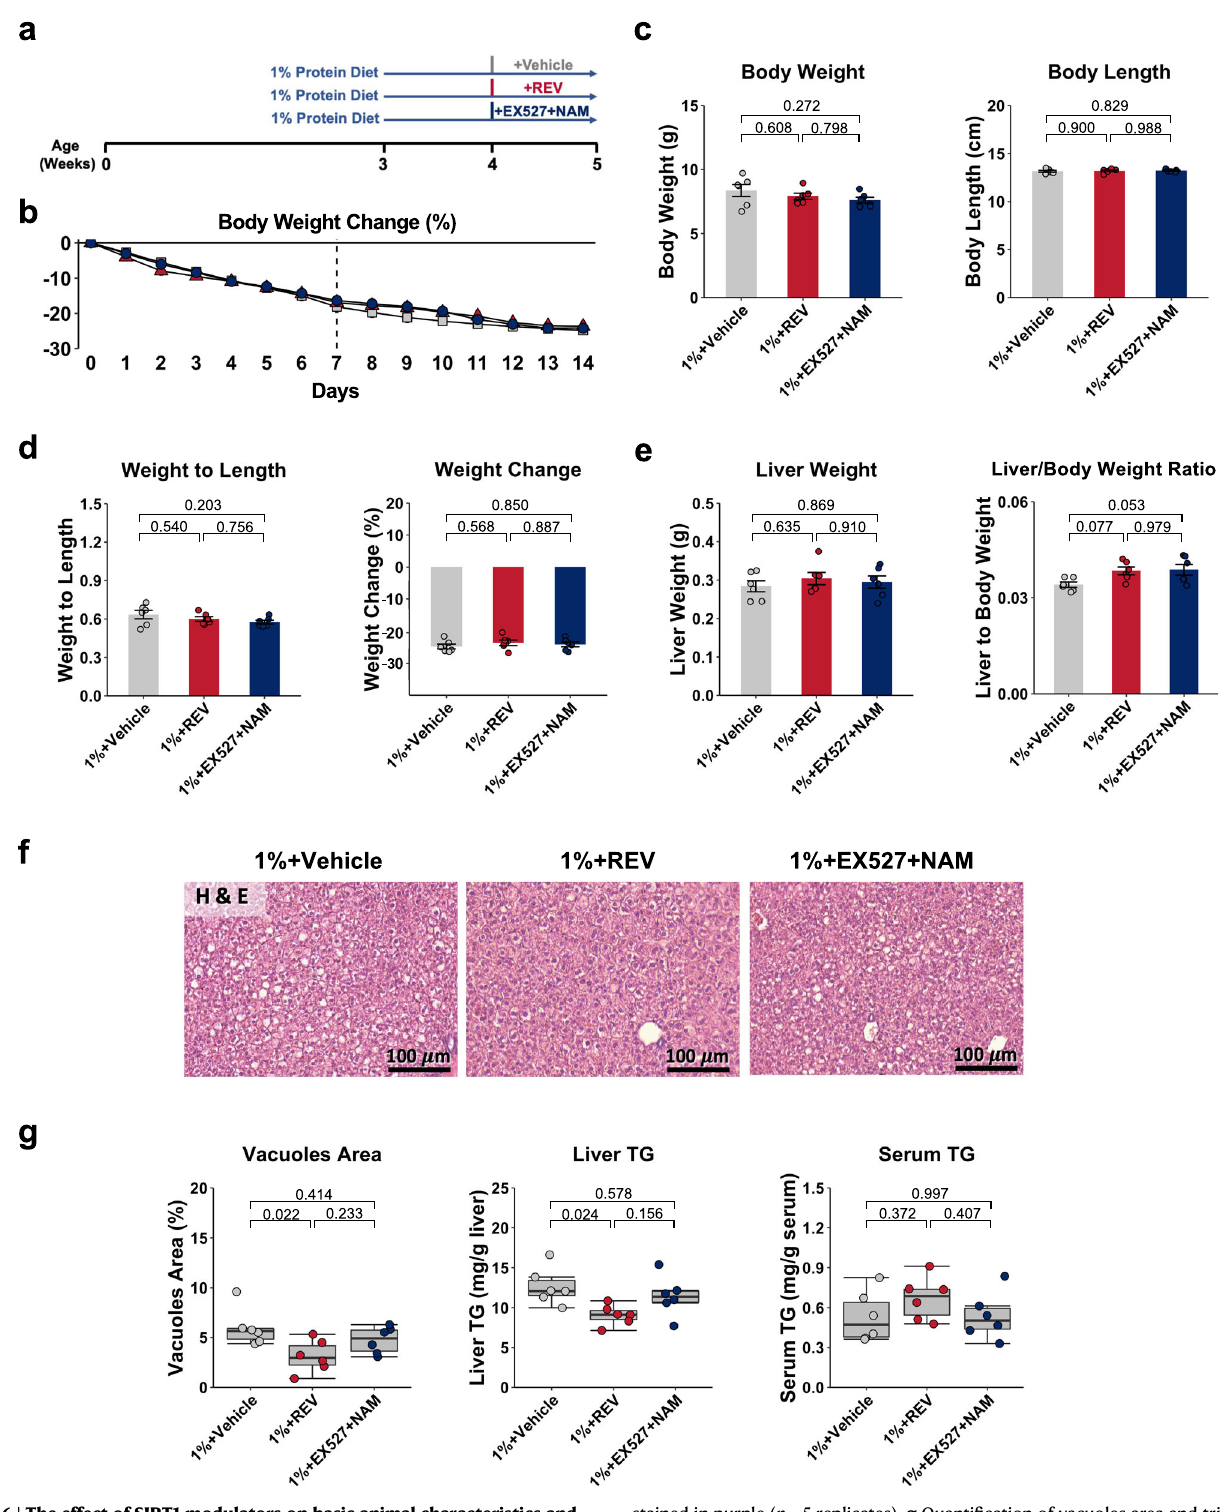
stained in purple ( n =5 replicates). g Quanti fi cation of vacuoles area and trigly- ceride (TG)levels( n =6 per group). One-wayANOVA followedbyTukey ’ s post hoc test. Unless stated differently in the fi gure legend, all n represents biologically independent samples. Data are shown as the mean±SEM. Data in box plots are shown as the fi rst to third quartile, whiskers encompass the range, and horizontal lines represent the